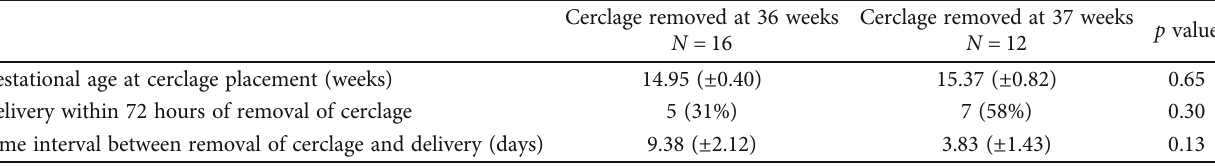
Table 3: Sub-analysis of women who underwent elective cerclage placement, comparing elective cerclage removal at 36 weeks versus those removed at 37